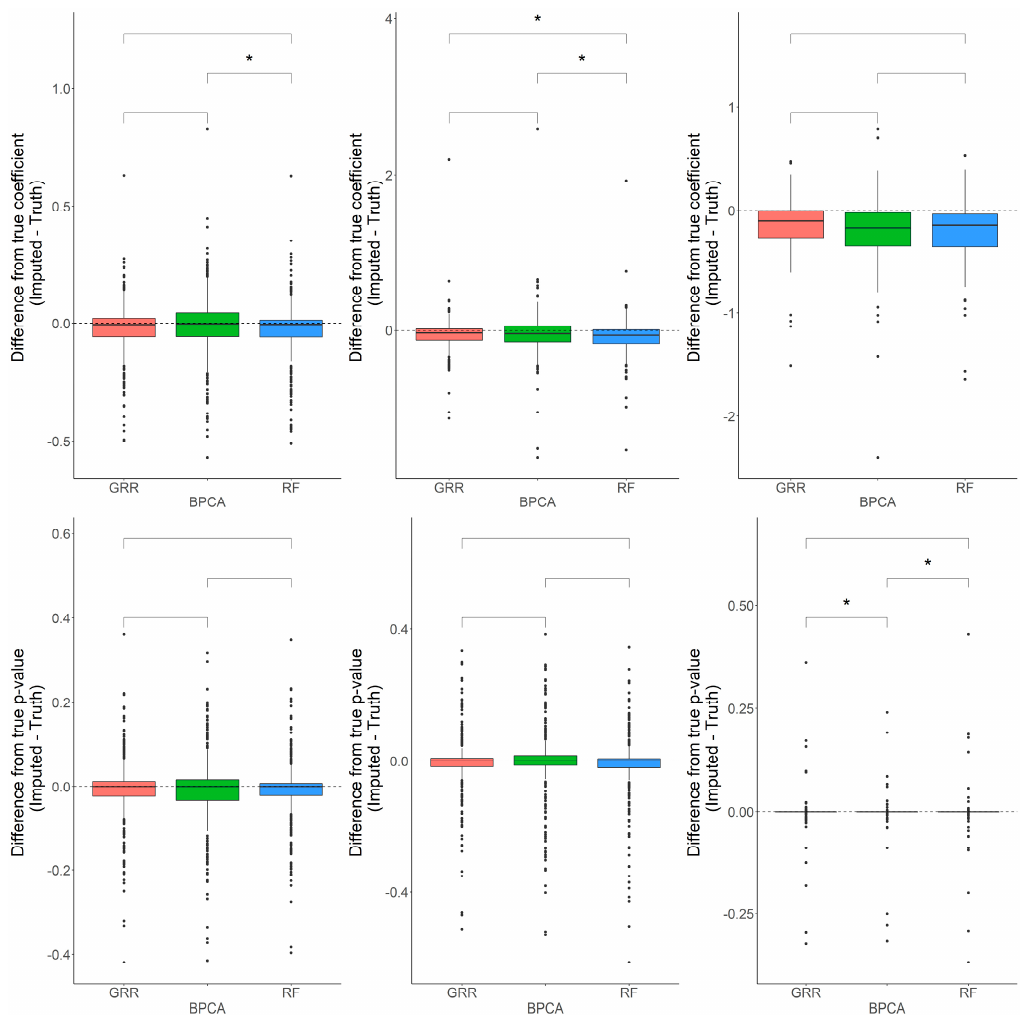
Figure 5. Evaluations of regression coefficient and regression p -value accuracy. Methods are listed across the x-axis. The differences between the regression coefficients (or p -values) computed on the complete data and the imputed data are shown on the y-axis. The top row demonstrates differences in regression coefficients evaluated in the baboon plasma samples for metabolites with <10%, 10–20%, and 20–30% missingness. The top row demonstrates differences in regression p -values evaluated in the baboon plasma samples for metabolites with <10%, 10–20%, and 20–30% missingness. The center line represents the median. The lower and upper box limits represent the 25% and 75% quantiles, respectively. The whiskers extend to the largest observation within the box limit ± 1.5 × interquartile range. Black dots represent single iterations of evaluating differences that are outliers. The p -values are based on pairwise testing with the Wilcoxon Rank Sum test (* corresponds to p ≤ 0.05; ** corresponds to p ≤ 0.01; *** corresponds to p ≤ 0.001; **** corresponds to p ≤ 0.0001).